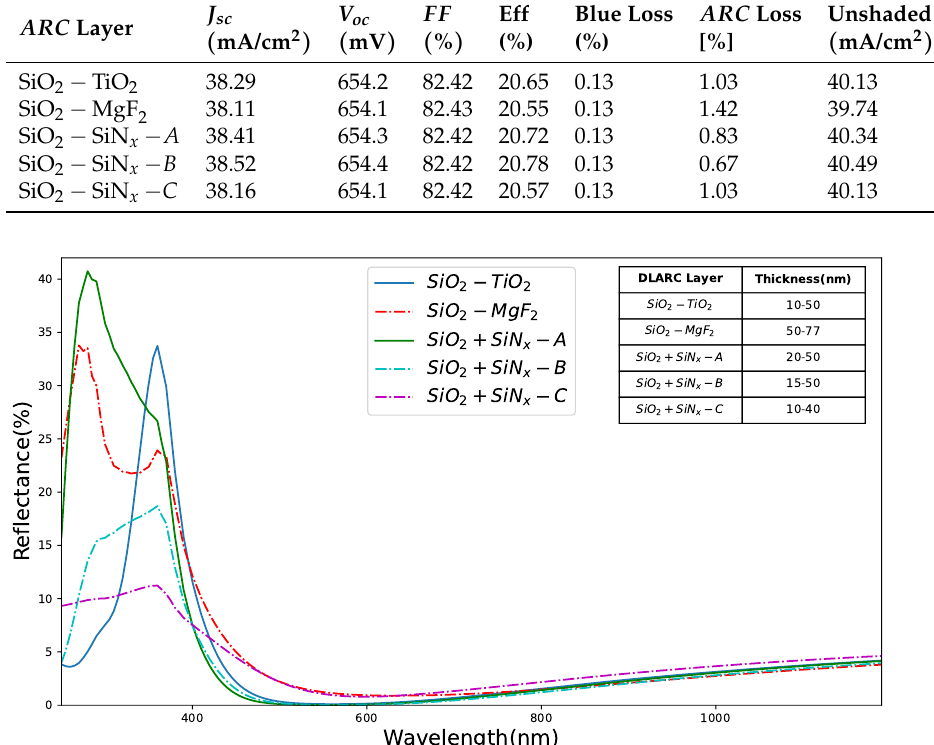
Figure 5. Reflectance spectra as a function of wavelength with optimized thickness of double-layer anti-reflection coating.